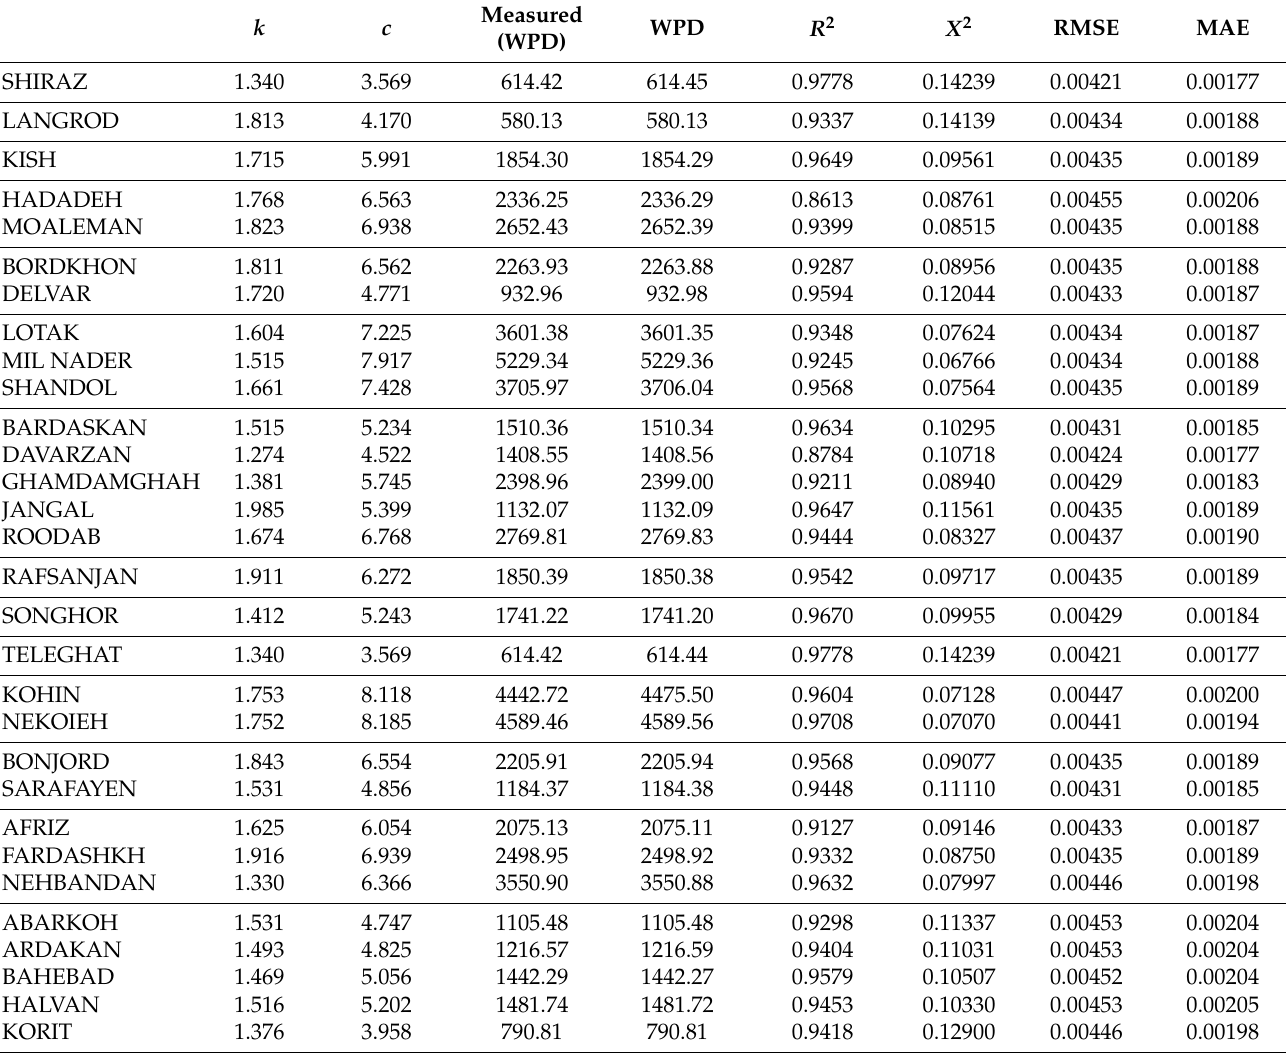
Table 4. Weibull parameters, wind power density, and errors using